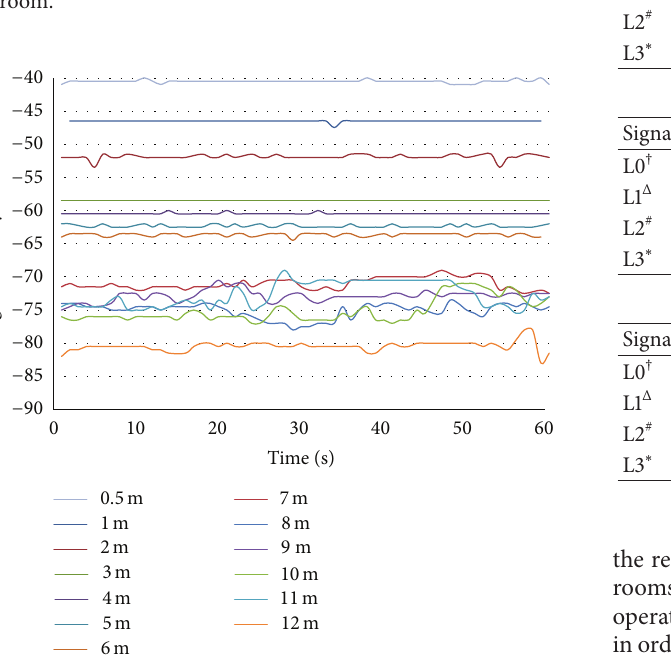
Figure 6: Signal strength measured within different ranges.